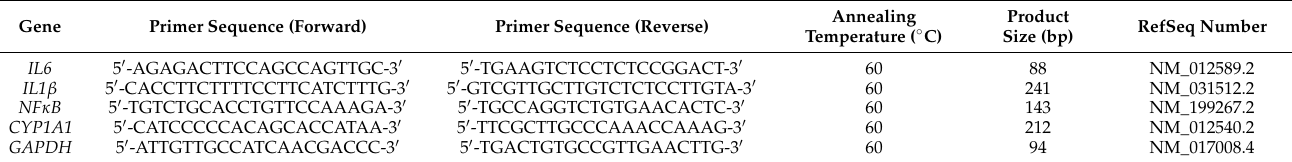
Table 2. Oligonucleotide primer sequences for quantitative reverse transcriptase polymerase chain reaction.